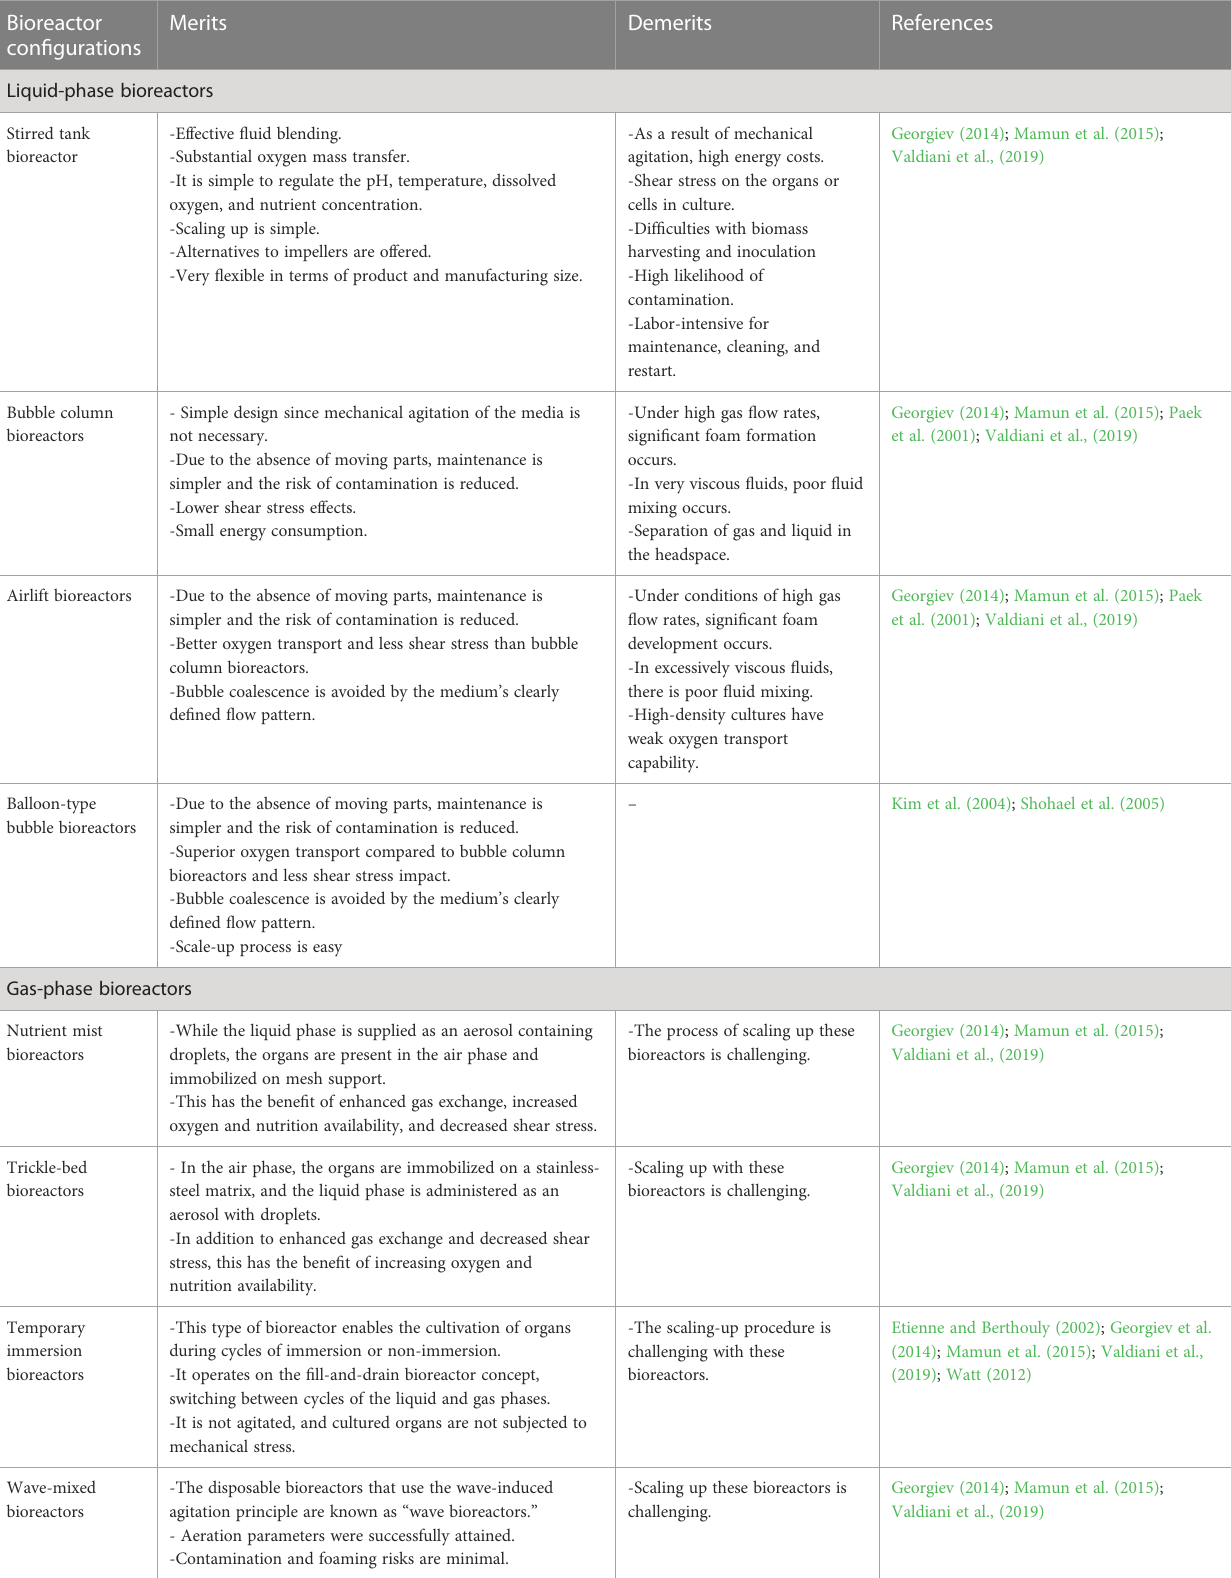
TABLE 1 Micropropagation of plants via organogenesis and somatic embryogenesis: Merits and demerits of bioreactor con fi